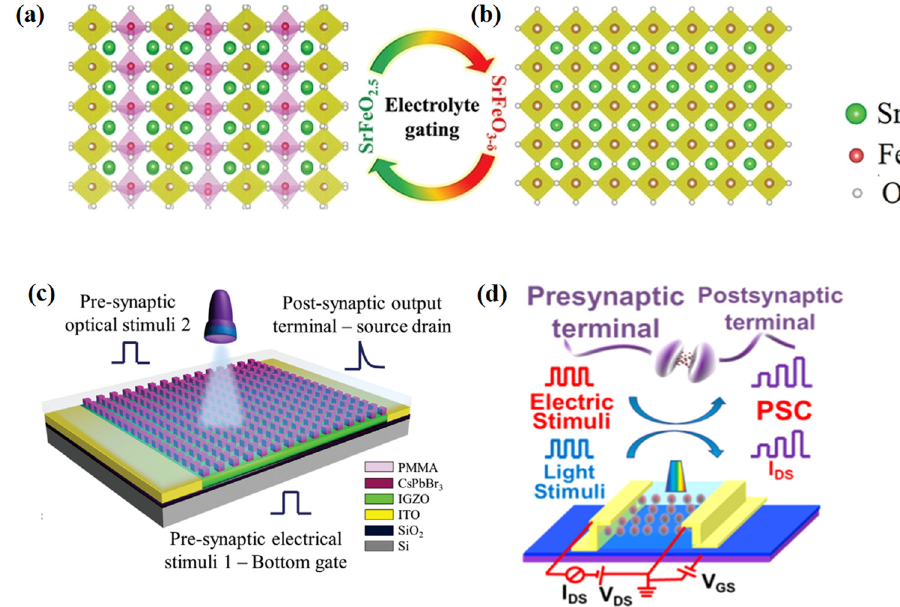
Figure 16: The schematic crystal structures of brownmillerite SrFeO 2.5 ( a ) and perovskite SrFeO 3 − δ ( b ) thin fi lms in the SrTiO 3 substrate. Reproduced with permission from ref. [ 144 ] . Copyright 2019, Wiley - VCH. ( c ) The proposed multi - gate transistor as arti fi cial synapses. Reproduced with permission from ref. [ 145 ] . Copyright 2020, Wiley - VCH. ( d ) Schematic of emulating a biological synapse by IGZO/ perovskite NPs/IGZO TFT. Reproduced with permission from ref. [ 146 ] . Copyright 2021, American Chemical